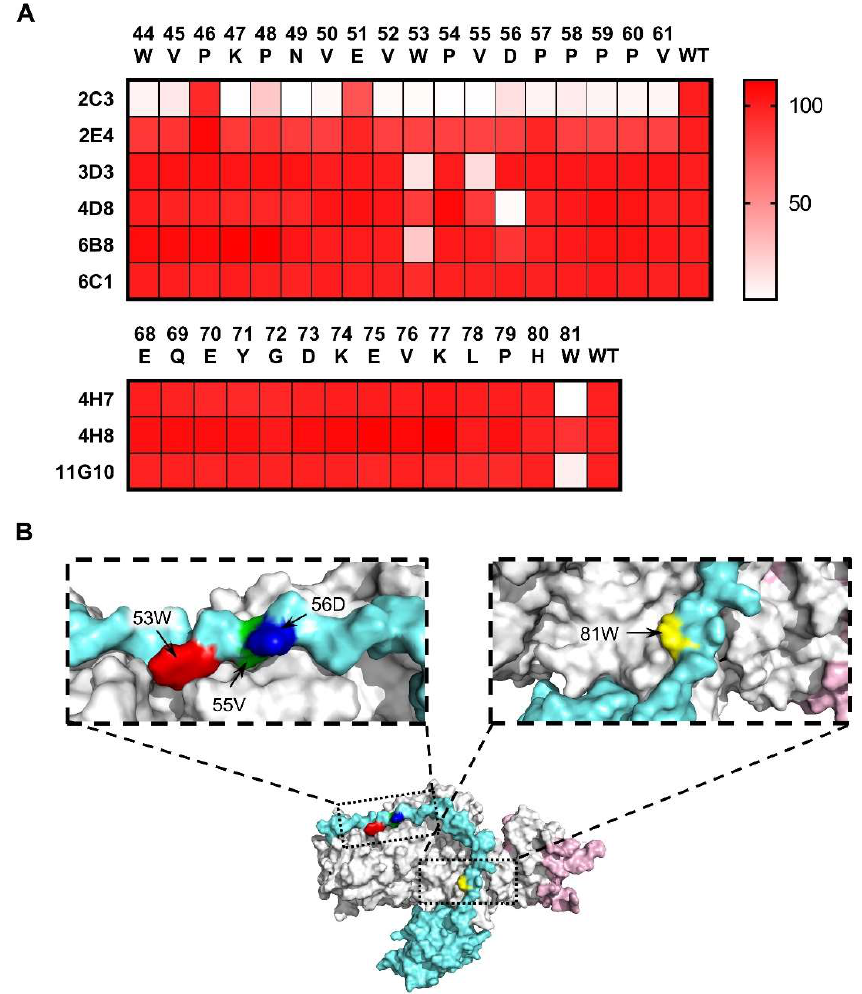
Figure 4. Key residue identification of anti-gp42 mAbs. ( A ) Alanine scanning libraries (gp42-44-61aa and gp42-67-81aa) were used to identify the key residues involved in gp42 and antibody interaction. Relative binding potency was calculated in percentage terms. ( B ) The key residues recognized by anti-gp42 mAbs are displayed. Amino acids ( 53 W, 55 V, 56 D and 81 W) are labeled in red, green, blue and yellow, respectively. Images were edited using PyMOL and the PDB accession number is 5T1D.